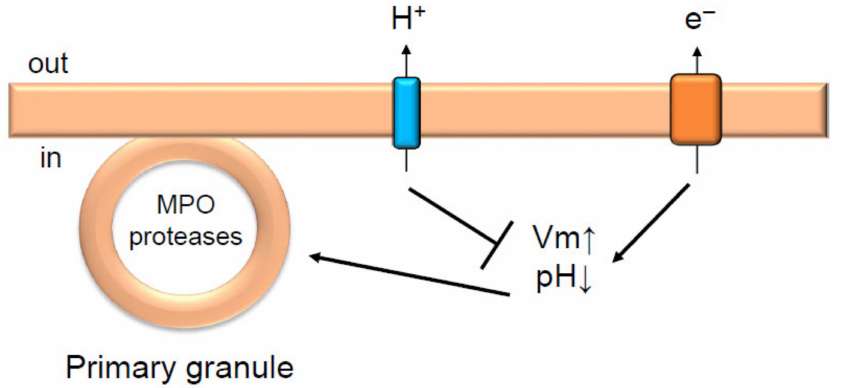
Figure 2. Hv1/VSOP inhibits degranulation in neutrophils. Hv1/VSOP inhibits degranulation of primary granules by regulating charge imbalance accompanied by NADPH oxidase activation [29]. Arrow and T arrow indicate promotion and inhibition, respectively, for Vm, pH and degranulation of primary granules. MPO is